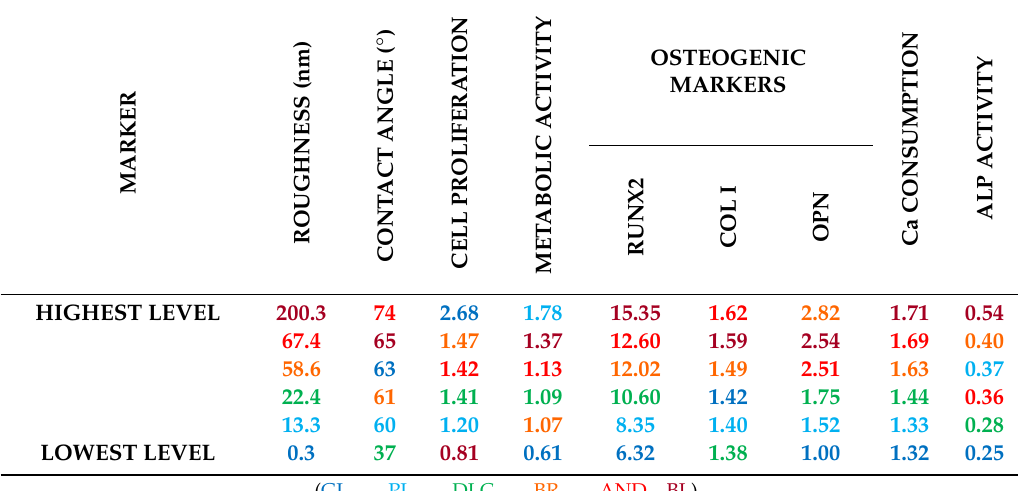
Table 3. A summary of the results of all analyses of samples on day 8 of cell cultivation. The data are sorted according to the values of the material properties and the cell performance, from highest to lowest. All values, with the exception of roughness and wettability, are dimensionless (i.e., they are normalized to glass on day 3, with the exception of OPN, which was normalized to glass on day 8). The samples are distinguished by color according to the legend below the